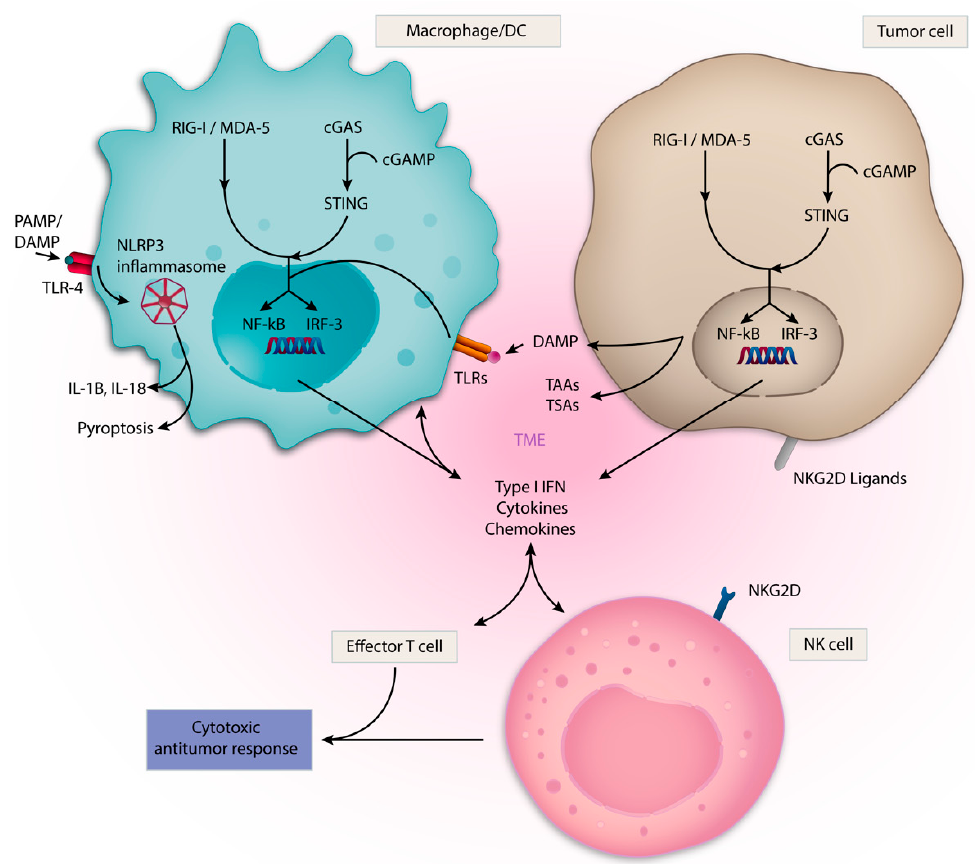
Figure 2. Innate Immune sensing pathways. A diverse set of pattern recognition receptors (PRRs) detect damage-associated molecular patterns (DAMPs), pathogen-associated molecular patterns (PAMPs) or tumor-associated antigens (TAAs) and activate innate immune cells within the TME. These sensors can also be expressed by tumor cells themselves. Multiple PRRs, including cGAS/STING, RIG-I and TLRs, promote transcription of proinflammatory genes via IRF-3 and NF-kb. These processes result in Type I IFN, cytokine and chemokine production, which supports a cytotoxic antitumor response mediated by effector T cells and NK cells. The NLRP3 inflammasome drives a proinflammatory response through IL ‐ 1 β and IL ‐ 18, in addition to mediating pyroptosis. NKG2D ligands activate NK cells.